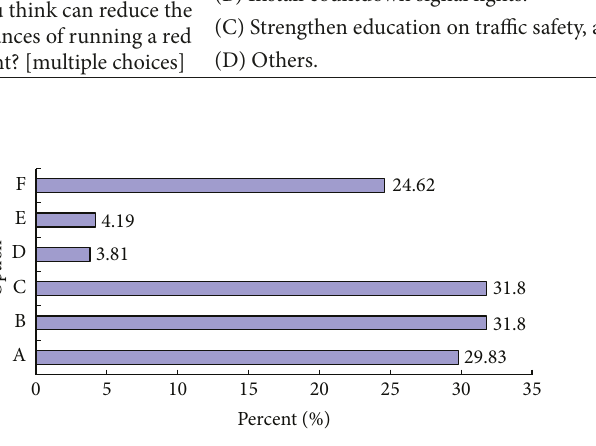
Figure 3: Distribution of reasons for running a red light at non- countdown signalized intersections.